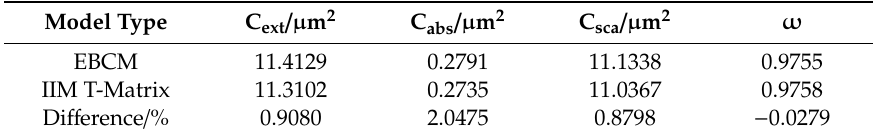
Table 3. The integral scattering parameters calculated by the IIM and EBCM T-Matrix methods for the cylindrical